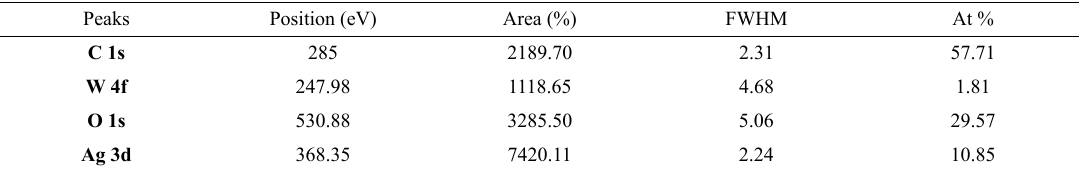
Table 2. Position, area, FWHM, and atomic fraction (At.%) values of the C, Ag, W, and O peaks for a typical XPS survey spectrum of α -Ag WO obtained by the MAH 2 4